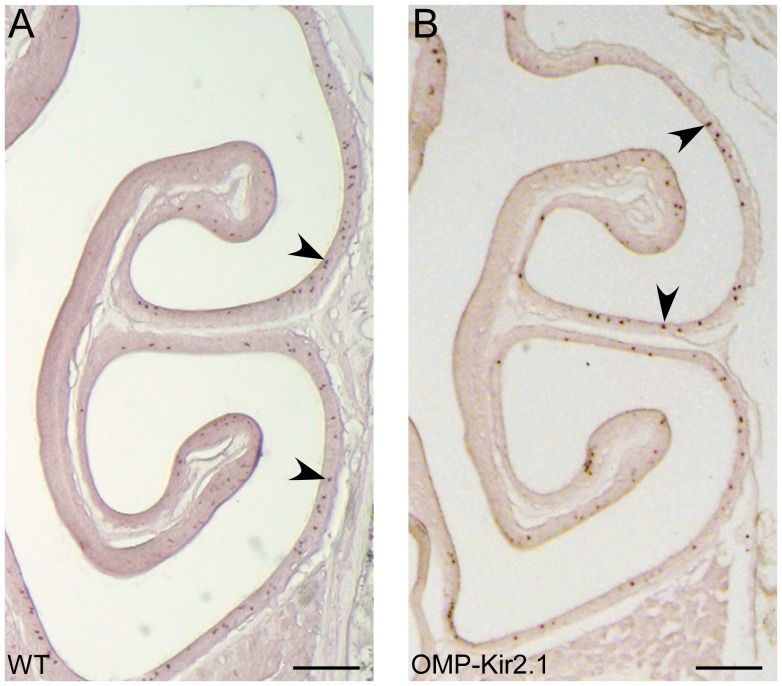
The MOR236-1 cell density is lower in OMP-Kir2.1 mice as compared with wild-type mice.The coronal sections from wild-type (A) and OMP-Kir2.1 (B) mice were hybridized with an antisense probe for MOR236-1 gene. Arrows mark examples of labeled cells. Scale bars = 0.2 mm.